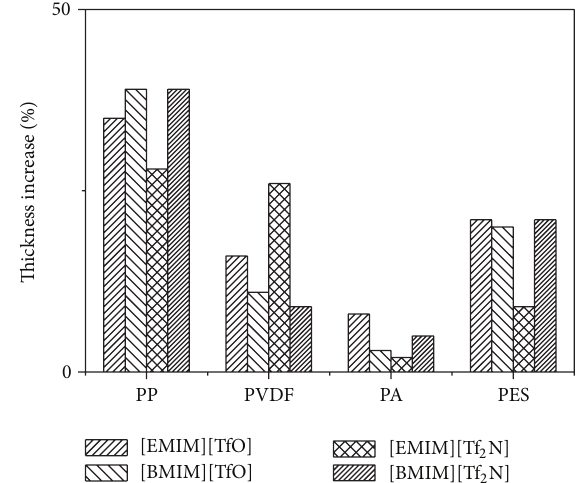
Figure 4: Increase of thickness of different supports saturated with ionic liquids after 120